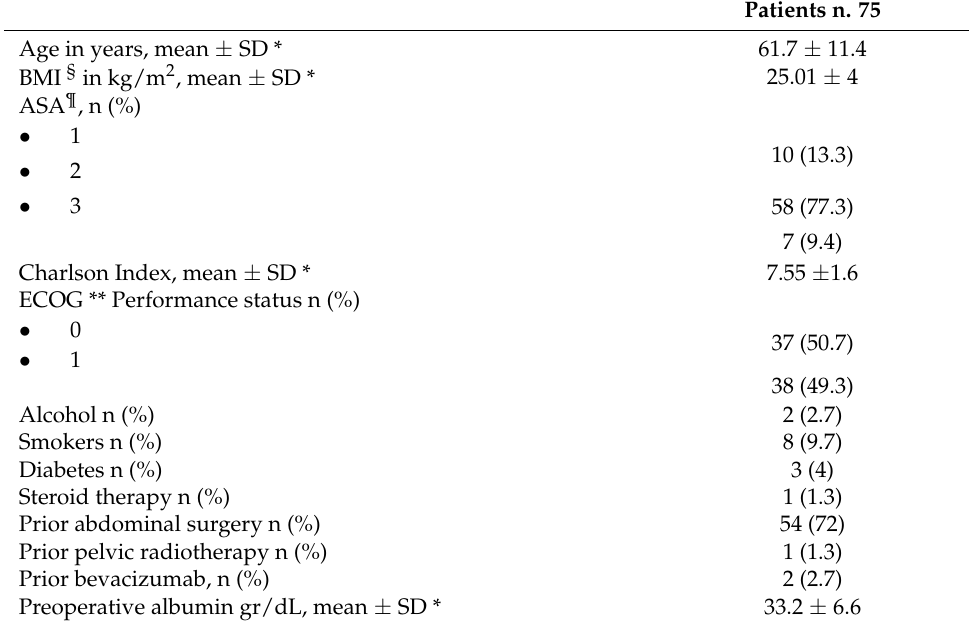
Table 1. Patient characteristics.